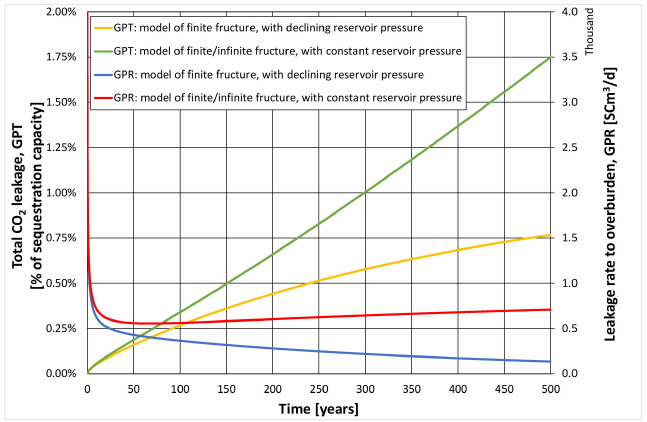
Figure 23. Rate and total CO 2 leakage to overburden. Scenarios for different fracture models and pressure conditions. Fracture range: lower anhydrite.